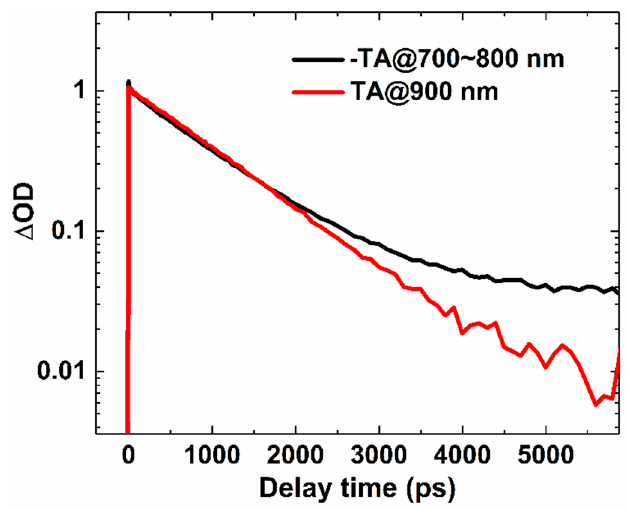
Figure4. TAkineticsofY6inchloroformsolutionattheindicatedprobewavelengthafterphotoexcitation Figure 4. TA kinetics of Y6 in chloroform solution at the indicated probe wavelength after at 700 nm with an excitation fluency of 2 × 10 15 photons cm − 2 photoexcitation at 700 nm with an excitation fluency of 2 × 10 15 photons cm − 2 .